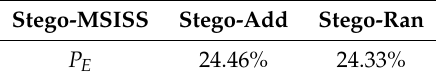
Table 6. The comparison of undetectability possibility results between Stego-MSISS with other embedding